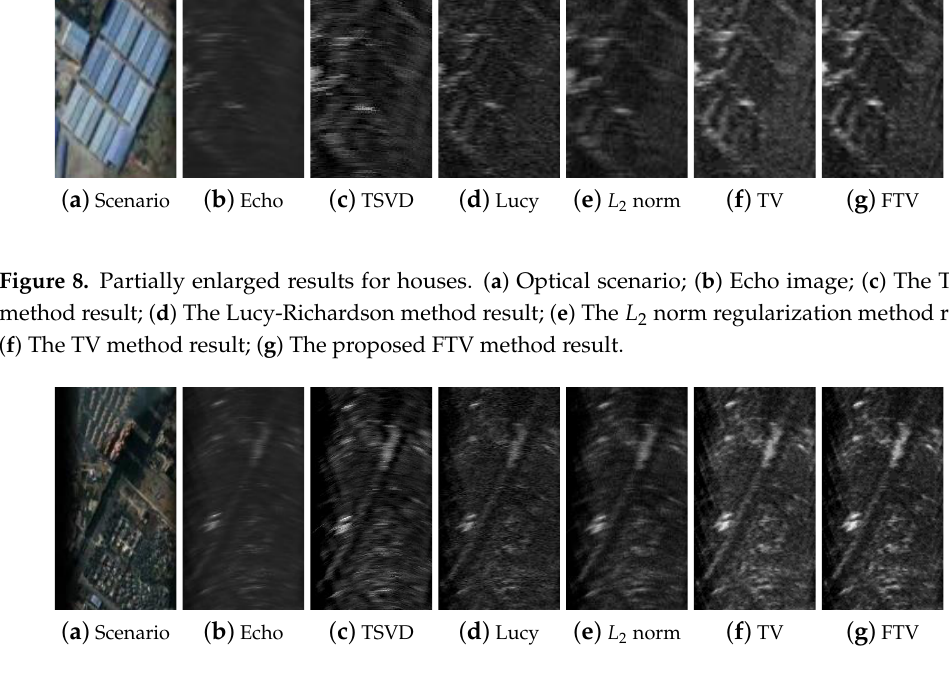
Figure 9. Partially enlarged results for road. ( a ) Optical scenario; ( b ) Echo image; ( c ) The TSVD method result; ( d ) The Lucy-Richardson method result; ( e ) The L 2 norm regularization method result; ( f ) The TV method result; ( g ) The proposed FTV method result.